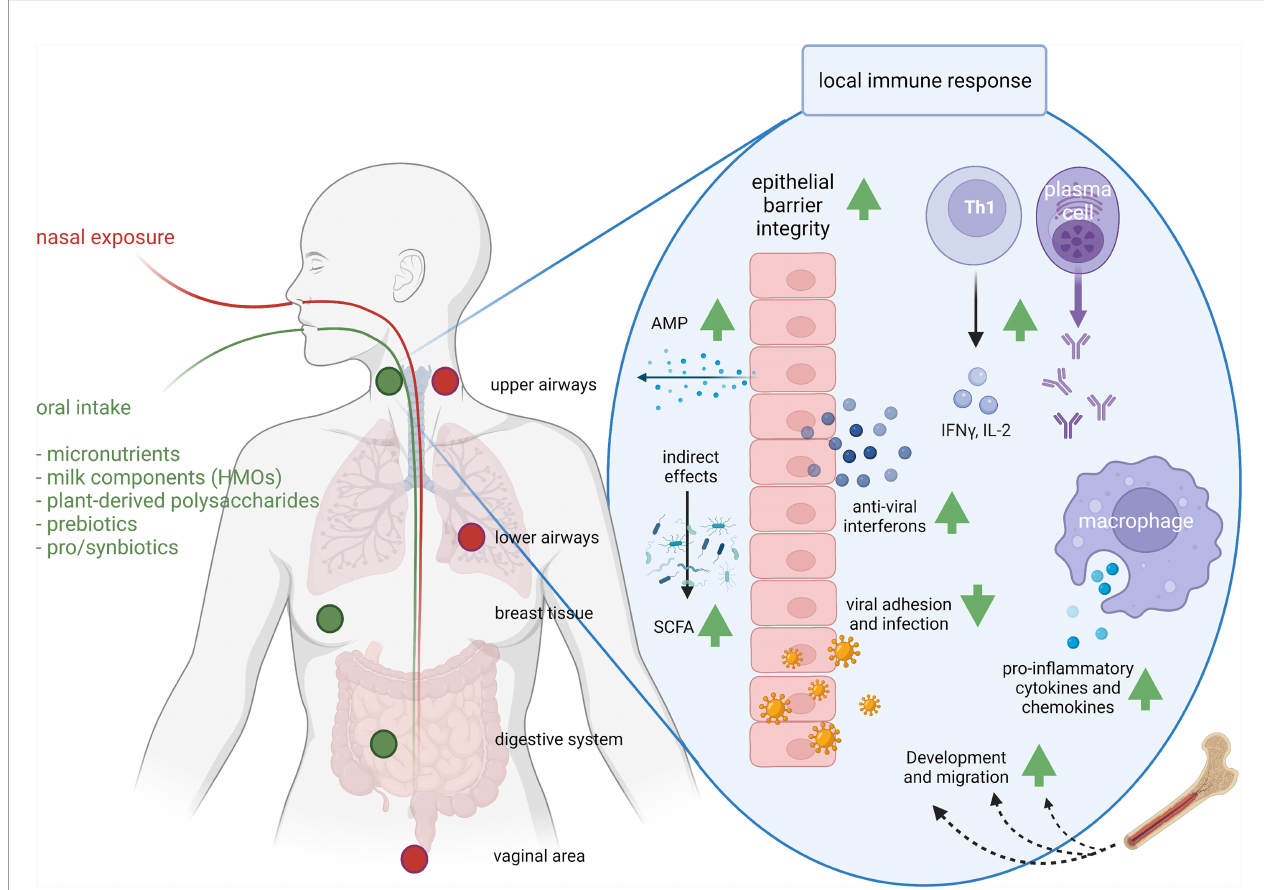
FIGURE 2 | Exposure routes and potential concerted immunomodulatory effects of food components. The route of administration determines the sites of immunomodulation. As a result of nasal exposure (the route that respiratory pathogens follow) pathogens or intranasal vaccines lead to IgA production in upper and lower airways and the vaginal area, and oral exposure leads to IgA production in the upper airways, breast and digestive system. Clinical studies have demonstrated support of respiratory immunity by many food components, whereas preclinical, ex vivo and in vitro studies identi fi ed possible mechanisms. For instance, milk- derived HMOs, pre- and probiotics modify the microbiome and SCFA production; vitamins A, C and D improve epithelial barrier integrity; vitamin D induces anti- microbial protein (AMP) secretion and acetate anti-viral interferon secretion in epithelial cells; viral adhesion and infection is reduced by zinc, bIgG, lactoferrin or HMOs; iron supports immune cell development and migration; bIgG and NDPs induce innate immune training and as a results increased cytokine and chemokine production; zinc and vitamin C support Th1 activity and IFN- g and IL-2 release; and selenium and vitamin C support antibody production. AMP, anti-microbial peptide; HMO, human milk oligosaccharides; IFN- g , interferon gamma; IL-2, interleukin-2; SCFA, short chain fatty acid. This fi gure was created with